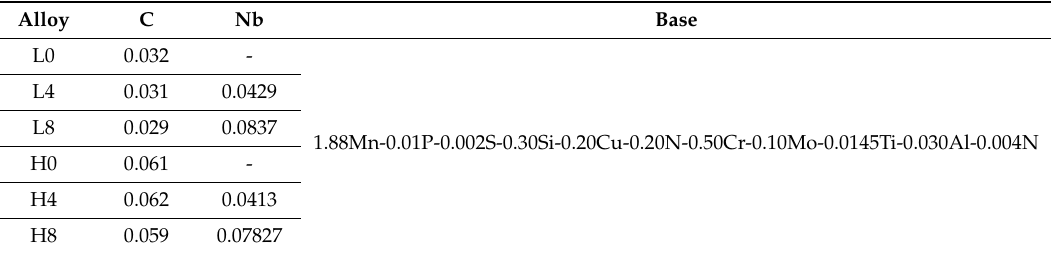
Table 2. Chemical composition of the experimental alloys in wt.%.